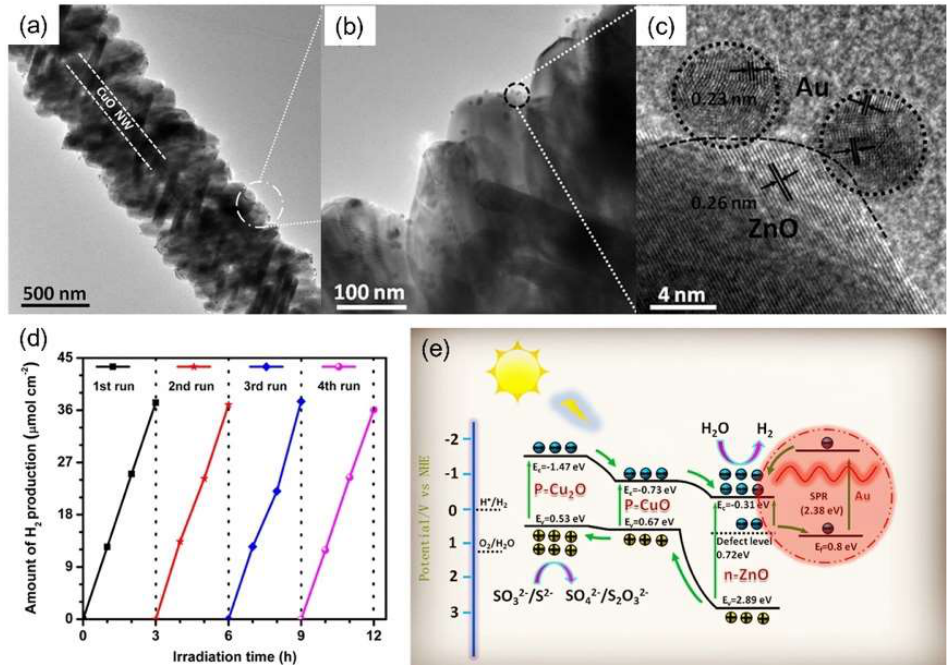
Figure 8. ( a – c ) Morphology and compositions characterizations of Cu x O/ZnO@Au hetero-nanostructures. ( d ) Recycling photocatalytic test of Cu x O/ZnO@Au. ( e ) Schematic illustration of photoexcited carrier dynamics in Cu x O/ZnO@Au. Copyright 2015 American Chemical Society.